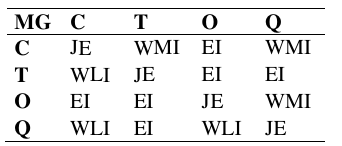
Table 3. Linguistic main criteria comparisons considering the